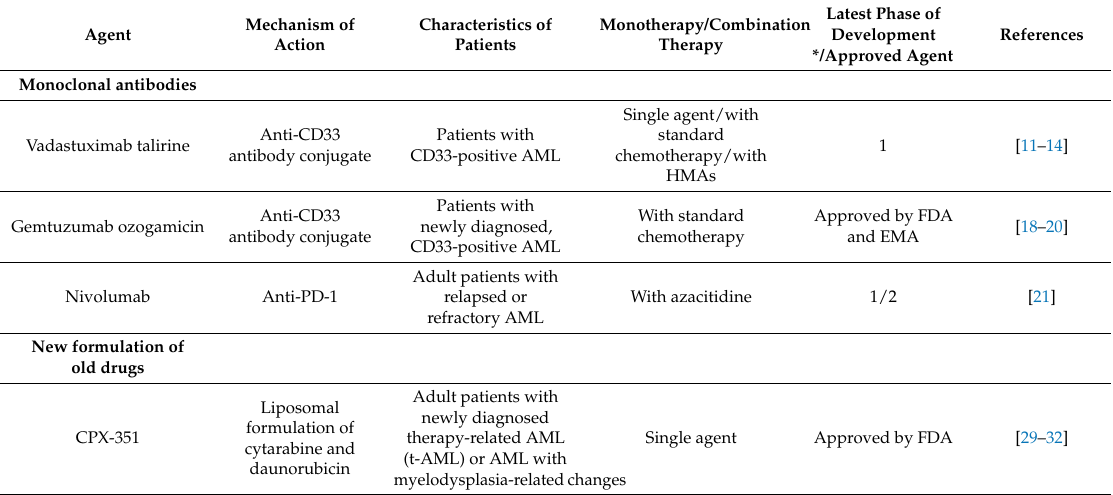
Table 1. Approved or selected emerging therapies for the treatment of AML. Mechanism of Characteristics of Agent Action